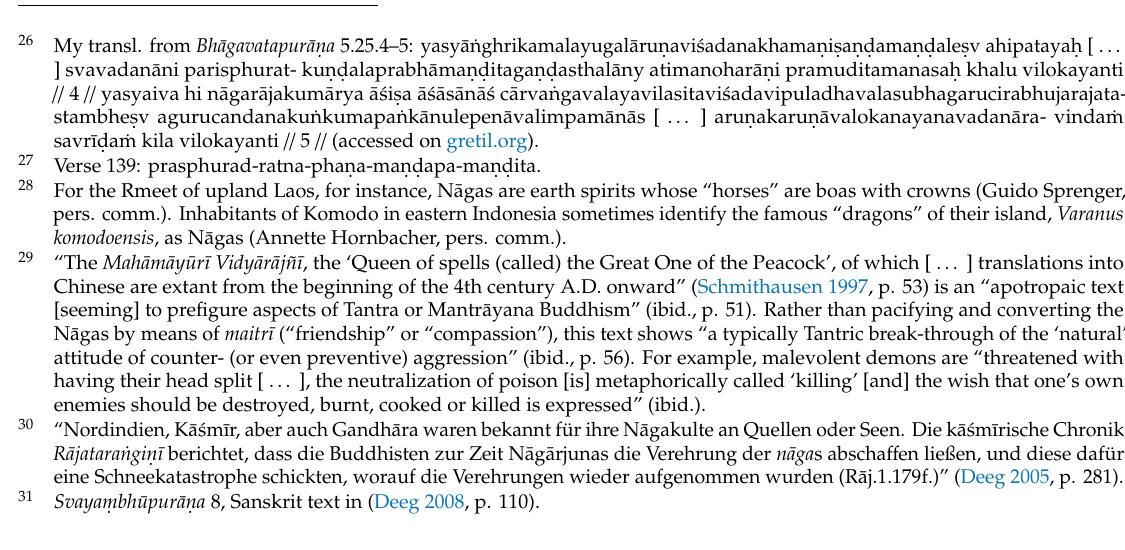
Figure 4. Mucalinda, a five- or seven-headed N ā ga king, rises like an aureole behind the Buddha, who is sitting in the lotos position ( padm ā sana ): ( a ) Brass figure from Thailand, purchased for the Marburg Museum of Religion in 1957 (photo by Heike Luu, acc.nr. Mq 027); ( b ) Gipsum replica of a Burmese figure, probably from Bagan, 11th—12th c. CE (photo by Georg Dörr, acc.nr. Mq 030; for a detailed examination on their provenience, cf. (Luu